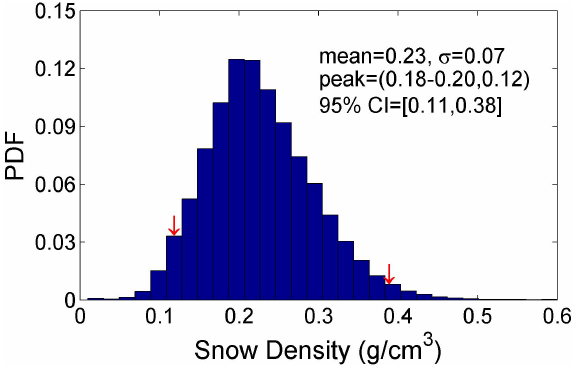
Fig. 10. Probability distribution function (PDF) of snow density for all data measured every 5 to 10 days interval. The bar is PDF of snow density; the down arrows represent the bracket 2.5% and 97.5% spectrum distribution of snow density. Mean and σ repre- sent the calculated mean and standard deviation of all snow den- sity (gcm − 3 ) , respectively. Peak stands for the peak PDF of snow density (right) and the corresponding snow density (left); 95% CI represents the range of snow density at 95% credibility interval; CI is the abbreviation for “credibility interval”.